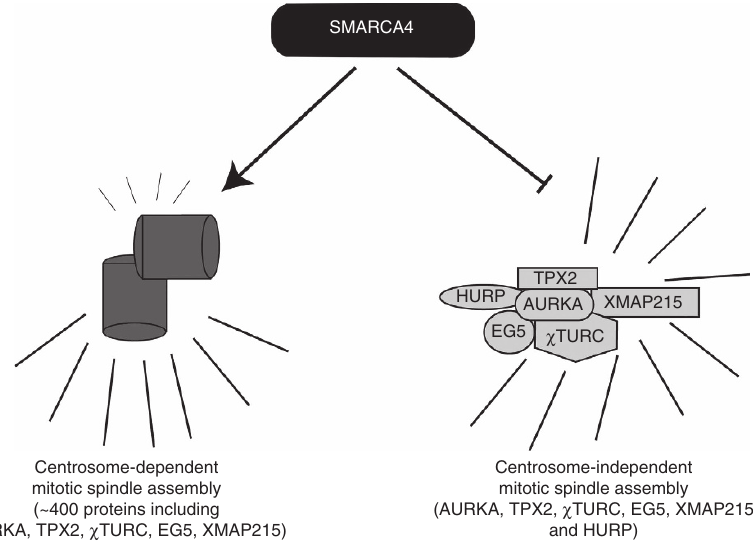
Figure 6 | Proposed model for the relationship between SMARCA4 and mitotic spindle assembly machineries. SMARCA4 may be necessary for the expression of a key component of the centrosome-dependent pathway for mitotic spindle formation and repress the centrosome-independent pathway of spindle formation. When SMARCA4 is lost, lung cancer cells upregulate HURP and become sensitive to its depletion. As HURP is a unique component of the centrosome-independent pathway normally dispensible for somatic cells, we speculate that hypersensitivity to Aurora kinase inhibitors is linked to a switch in the mechanisms for mitotic spindle